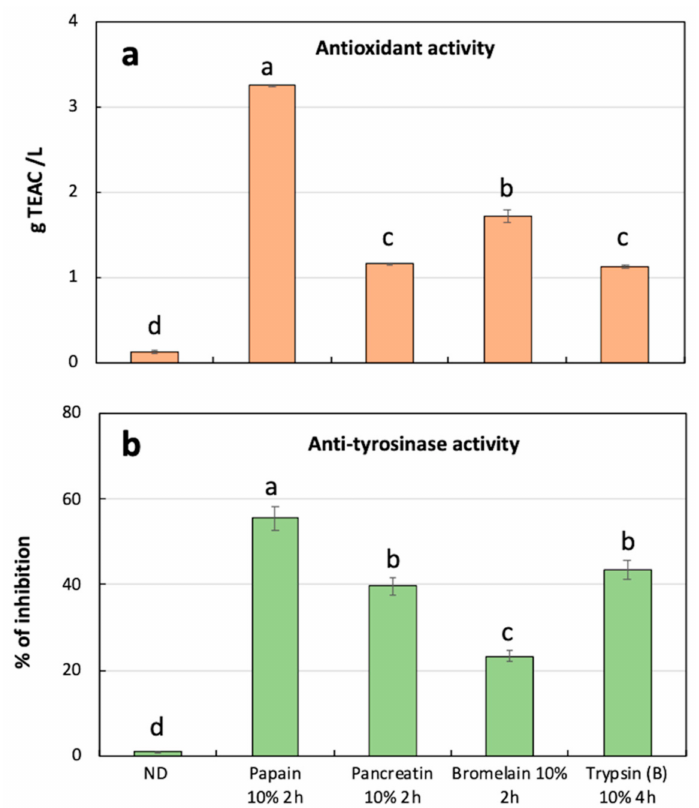
Figure 2. Quantification of antioxidant activity ( a ) and anti-tyrosinase activity ( b ) in intermediate fractions obtained after calf fleshing hydrolyses at different digestion conditions. ND, average of not digested control at 50 ◦ C and 37 ◦ C. Statistically significant differences among the same analysis were indicated by different letters, according to one-way ANOVA followed by post hoc Tukey’s multiple pairwise comparison ( p < 0.05). TEAC, Trolox equivalents antioxidant capacity. Data are the mean ± SD ( n =